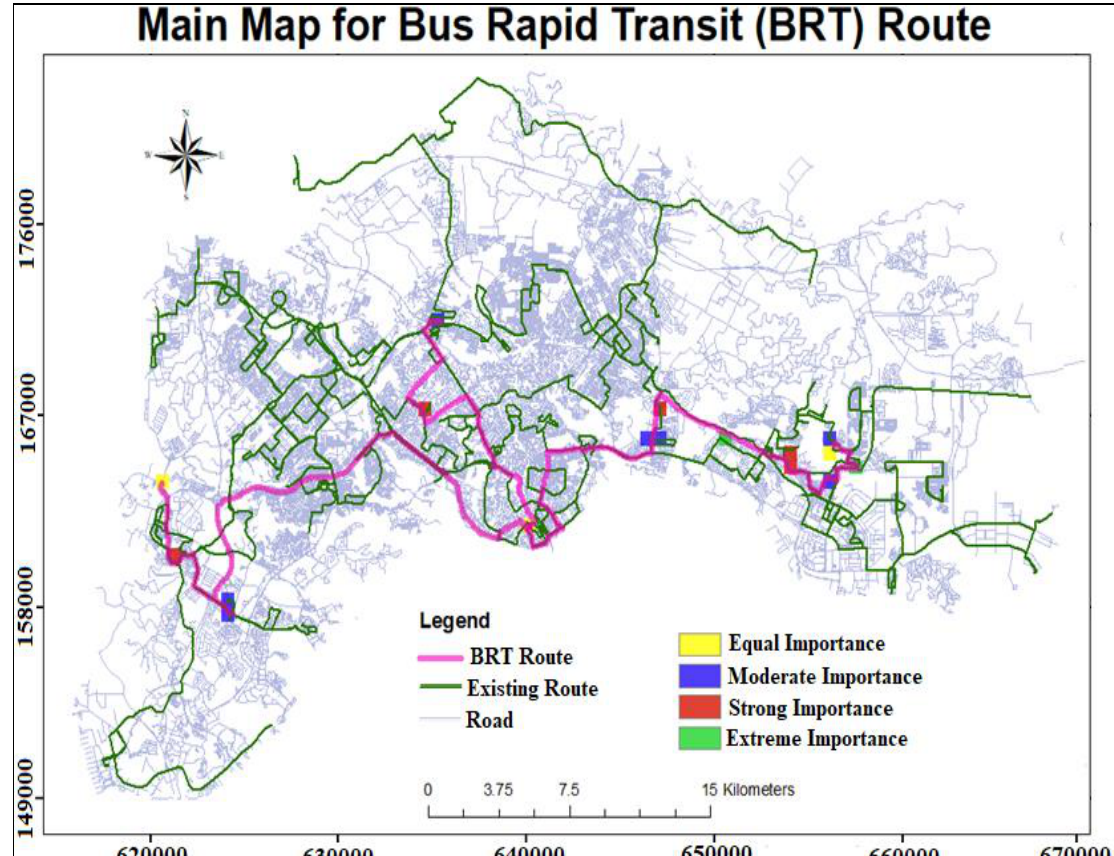
Figure 12 Bus Rapid Transit (BRT) Route